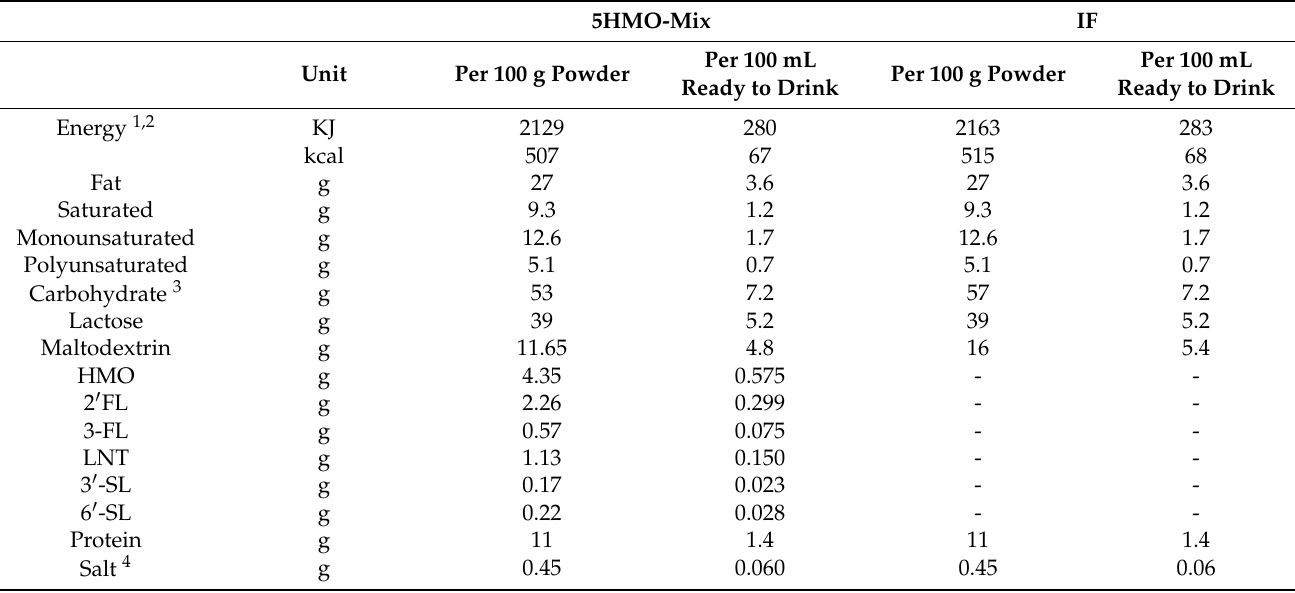
Table 1. Energy, macronutrients, and HMOs in 5HMO-Mix formula and the control IF (per 100 g formula powder and per 100 mL ready-to-drink). Nutritional values for micronutrients are provided in Table S2 in the Supplementary